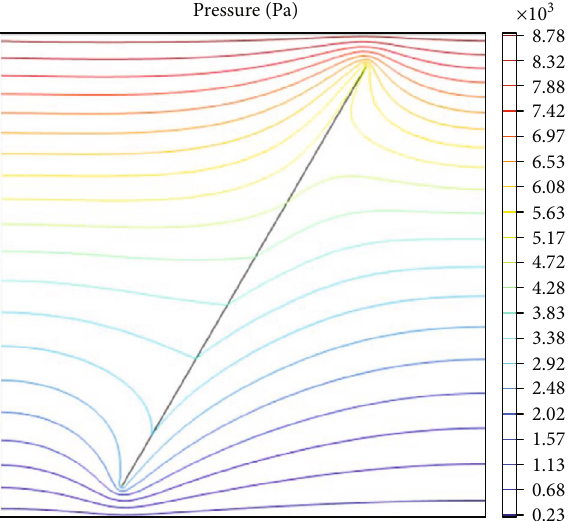
Figure 9: The pressure distribution contour of the MFF